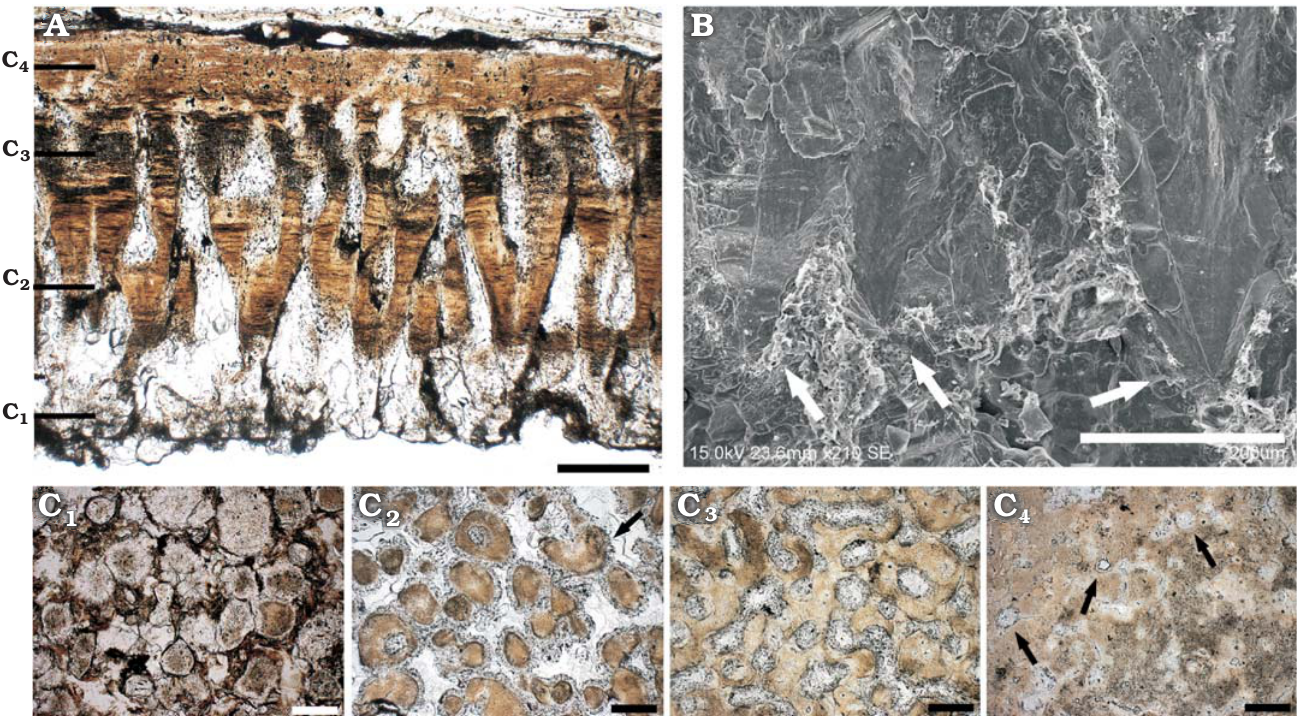
Fig. 3. Dendroolithid eggshell microstructure of Placoolithus tumiaolingensis (Zhou, Ren, Xu, and Guan, 1998) comb. nov. from the Upper Cretaceous of the Tumiaoling outcrop, Yunxian, Hubei Province, China. A . Radial thin section, lines at the left side indicate rough positions of C 1 –C 4 in descending order. B . Secondary eggshell units (white arrows) in radial section (SEM). C . Tangential thin sections of eggshell, near the inner surface (C 1 ), in the middle part (C 2 ), near the outer surface (C 3 ), and through the compact layer (C 4 ); black arrows indicate a worm-like section formed by multiple eggshell units Description. — Size and structure of egg clutches (Fig. 2, Table 1): TML 4 is the largest and best-preserved clutch at the Tumiaoling outcrop, containing 77 eggs in total. This clutch